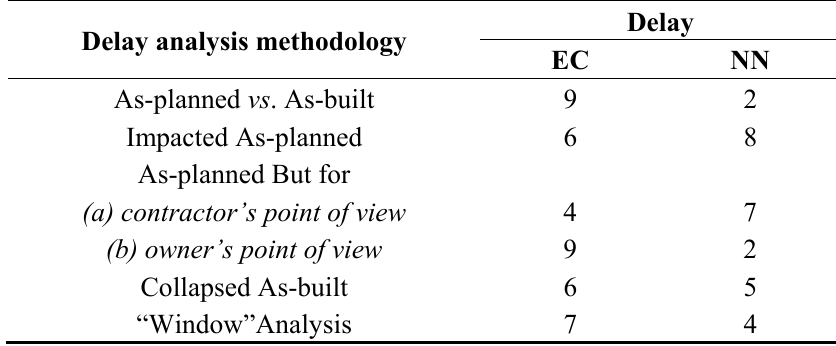
Table 4. Summary of delay analysis results for the case